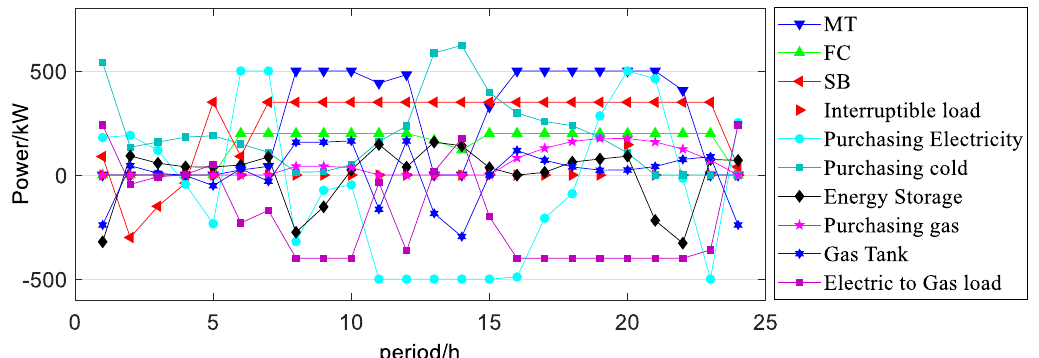
Figure 8. Optimal operation scheme of the IES for a typical summer day (Micro-turbine: MT, FC: Fuel Cell, SB: Storage Battery).